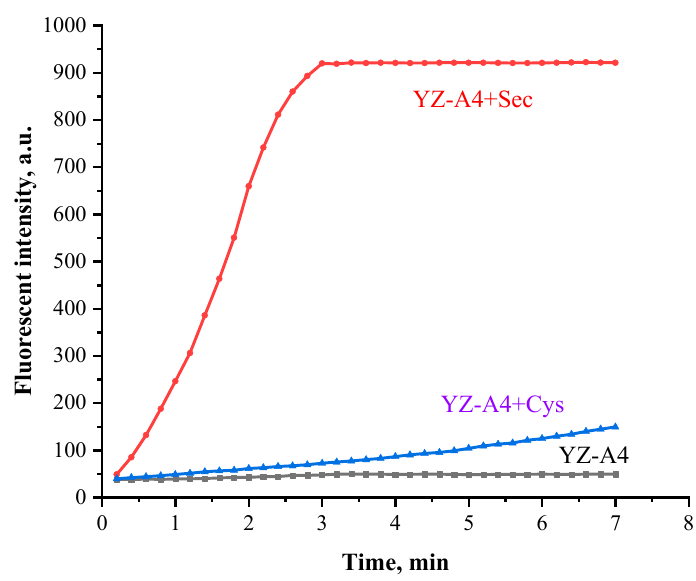
Figure 2. Time-dependent fluorescent intensity of 10 μ M YZ-A4 at 614 nm in the absence (black) and presence of 100 μ M Sec (red), and presence of 100 μ M Cys (blue) in PBS (10 mM, pH 7.40, containing 1% DMSO as cosolvent), excited at 550 nm.